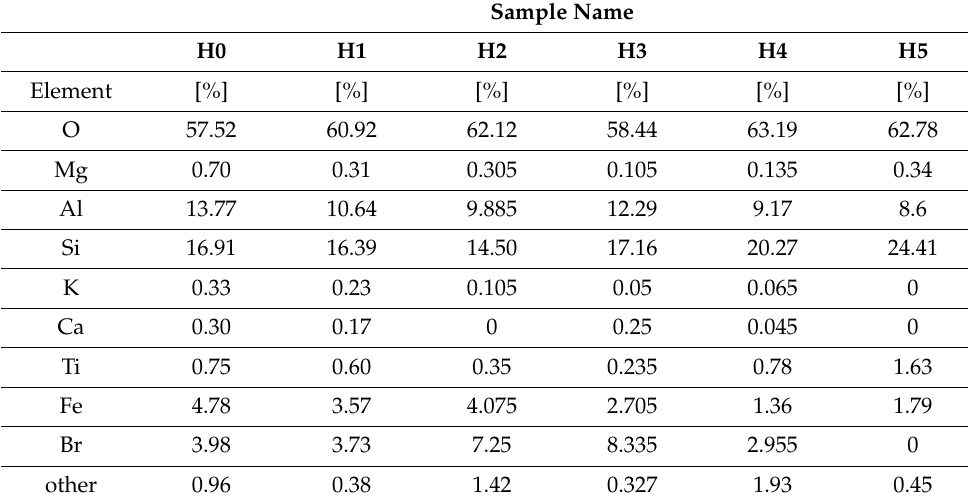
Table 3. The chemical composition of raw and modified halloysite samples obtained from SEM- EDX analysis. Values present a percentage of particular elements in the analyzed sample. Samples, treatment details, and names are described in Table